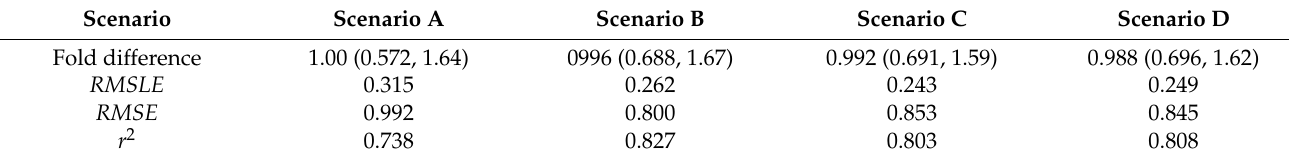
Table 4. Statistics for the four scenarios. Smaller RMSLE and RMSE values would imply a better fitting to the observations. In the case of the fold difference and r 2 , the model r 2 values closer to 1 have better description power for the observed data. The fold differences are presented with the medians and the 5th to 95th